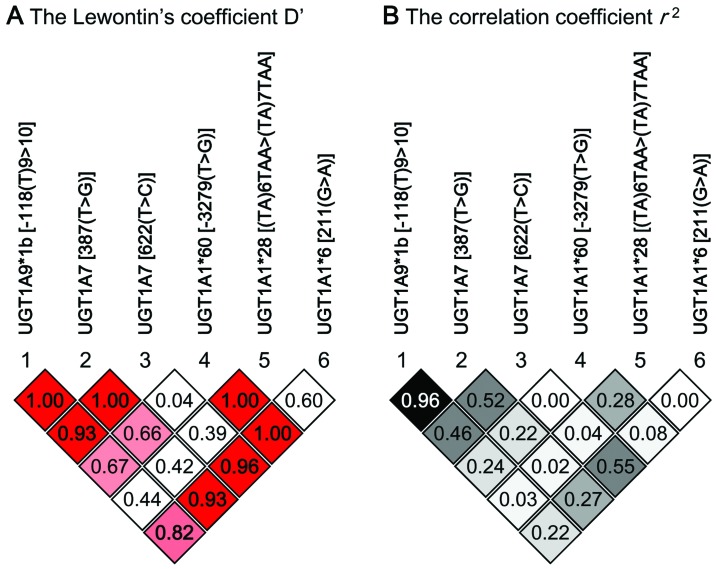
Pairwise linkage disequilibrium relationships between the UGT1A variants. (A) The Lewontin’s coefficient D′ and (B) the correlation coefficient r2 are represented as values and colors [in panel A, log of the odds (LOD) ≥2 shades of pink/red, LOD <2 and D′=1 is blue, and LOD <2 and D′ <1 is white. In panel B, r2<0.01 is white, 0.01≤r2 <0.95 is shades of grey, and r2≥0.95 is black] in each box.